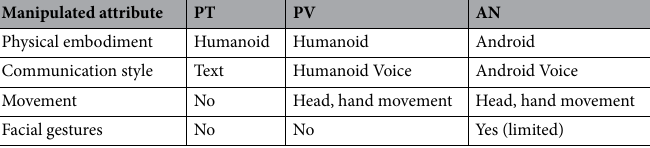
Table 1. The manipulated attributes of PT, PV, and AN to represent different levels of anthropomorphism.